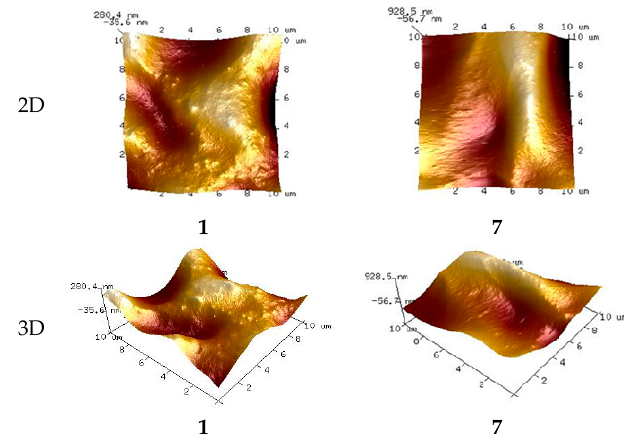
Figure 2. 2D and 3D-atomic force microscopy (AFM) images of PIMs with no carriers: ( 1 ) and ( 7